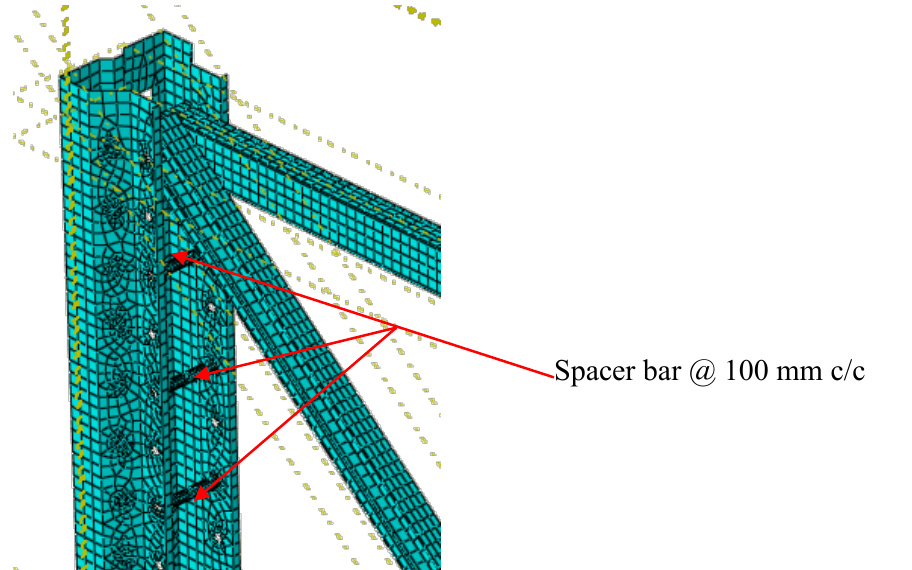
Spacer bar @ 100 mm